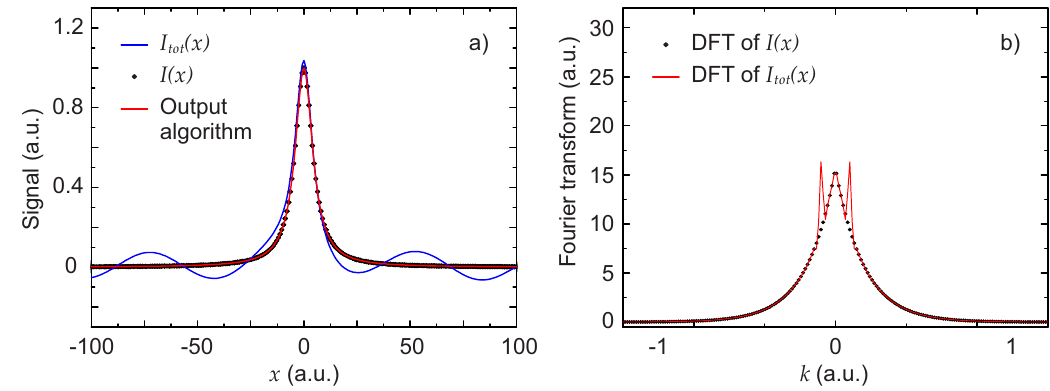
Figure 4. First scenario: disturbance with an FSR comparable to the line width. ( a ) simulated experimental total signal I tot ( x ) (blue line), Lorentzian line shape signal I ( x ) (black dots) and extracted signal obtained with the algorithm (red line); ( b ) DFT of the total signal | F ( I tot ( x ))( k ) | (red line) and DFT of the Lorentzian signal | F ( I ( x ))( k ) | (black points).